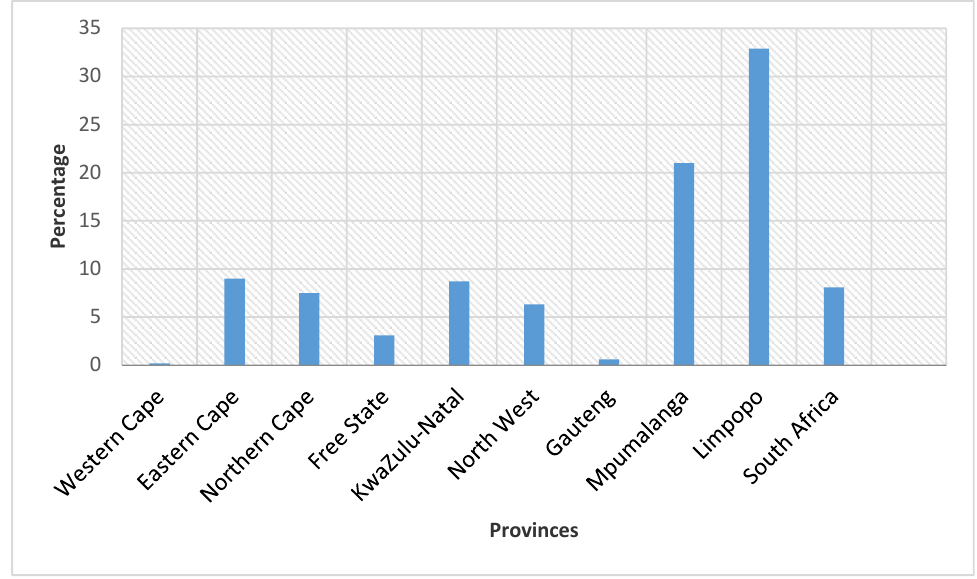
Figure 5. Percentage of households which use firewood and coal for cooking. Adapted from [36]. Table 5 shows the number of consumer units receiving basic electricity in the Eastern Cape compared to other provinces in South Africa, Table 5. Number of consumer units receiving basic electricity in the Eastern Cape compared to other provinces in South Africa.